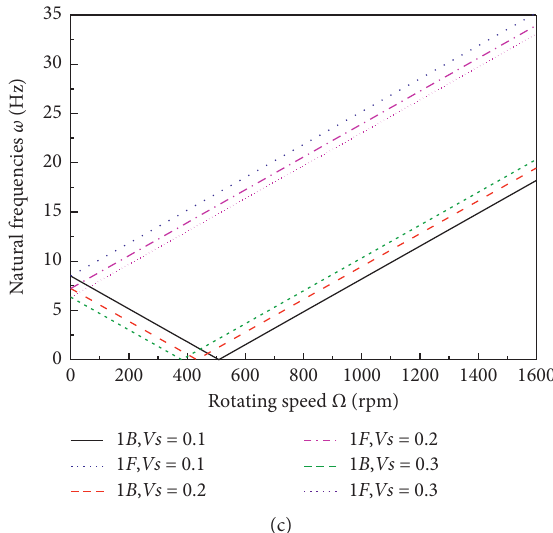
Figure 6: The first natural frequencies versus rotating speed of the tapered composite rotating shaft for different SMA fiber fractions � 0 . 005), (a) C-C; (b) S-S; (c) ( σ � 0 . 5 , θ � 30 ° ,T � 50 ° C , ε 0